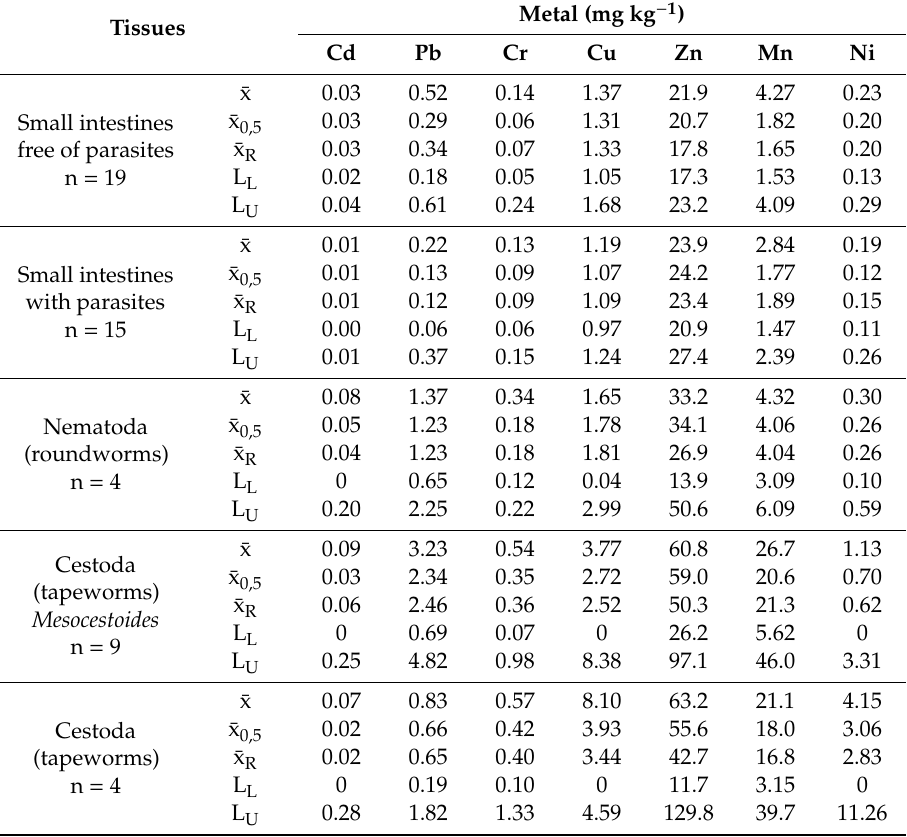
Table 1. Heavy metal contents in fox intestines and in their